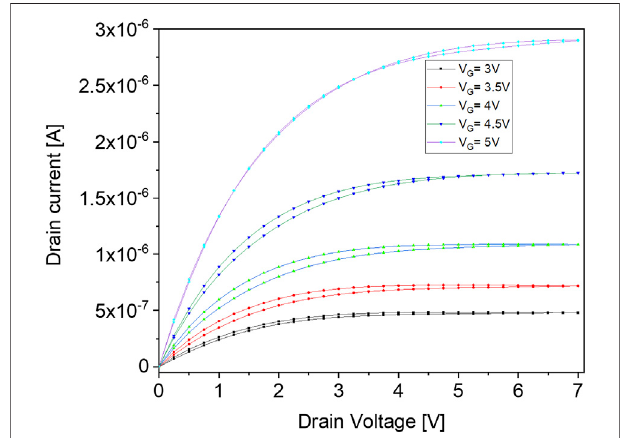
FIGURE 7 | Output characteristics of the TFTs with 2 layers YAlO x